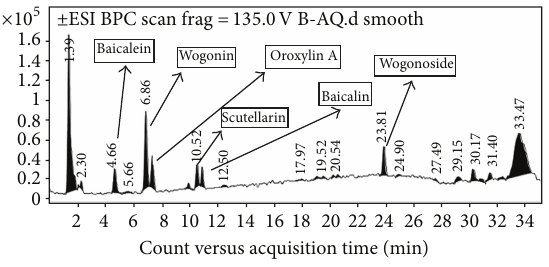
Figure 6: LC-MS chromatogram of the bioactive ethanol extract of the root of Scutellaria baicalensis Georgi.